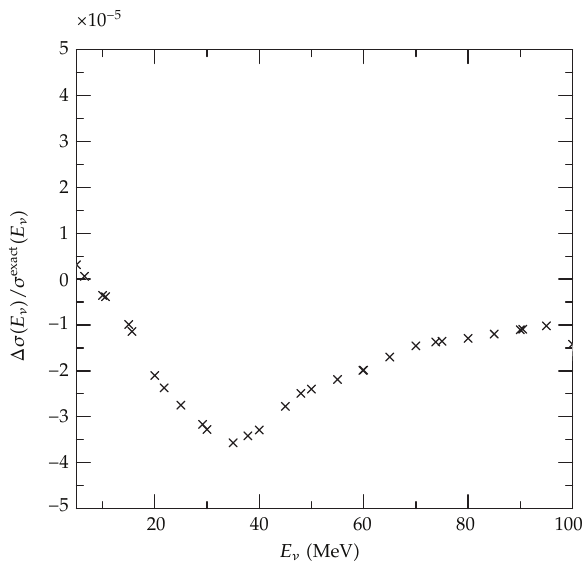
Figure 2: Numerical errors in the cross section for the charged-current neutrino-nucleus scattering o ff 100 Mo due to the use of barycentric Lagrange interpolation. The errors are shown for various energies E ν of the incoming neutrino. In the figure, Δ σ (cid:3) E ν (cid:4) (cid:7) σ approx (cid:3) E ν (cid:4) − σ exact (cid:3) E ν (cid:4)